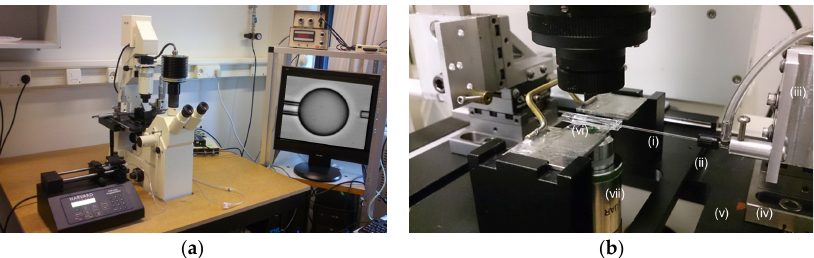
Figure 2. The micropipette manipulation station. ( a ) The setup consists of an inverted microscope to place and visualize the micropipette tip, operated by micromanipulators, connected to a pressurization system (μatm to matm); the samples are placed in a custom-made microchamber and all the experiments are recorded in real time by using a side-port camera for subsequent analysis. ( b ) The micropipette (i) is mounted via a chuck (ii) in a custom-built holder controlled by micromanipulators (iii), mounted on a stage micrometer, (iv) bolted firmly to the microscope platform (v). The image of the pipette tip in the microchamber (vi) is viewed via a 40× objective lens (vii). A temperature-controlled chamber allows the sample temperature to range from 5 °C to 50 °C.